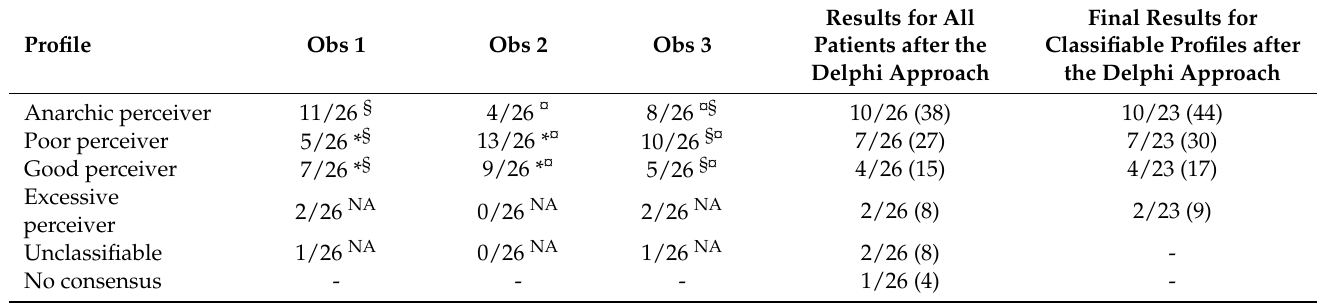
Figure 4. Perception profiles of the 26 asthmatic children after the Delphi approach. Table 2. Characterization of the perception profile according to the 3 observers and after Delphi approach .